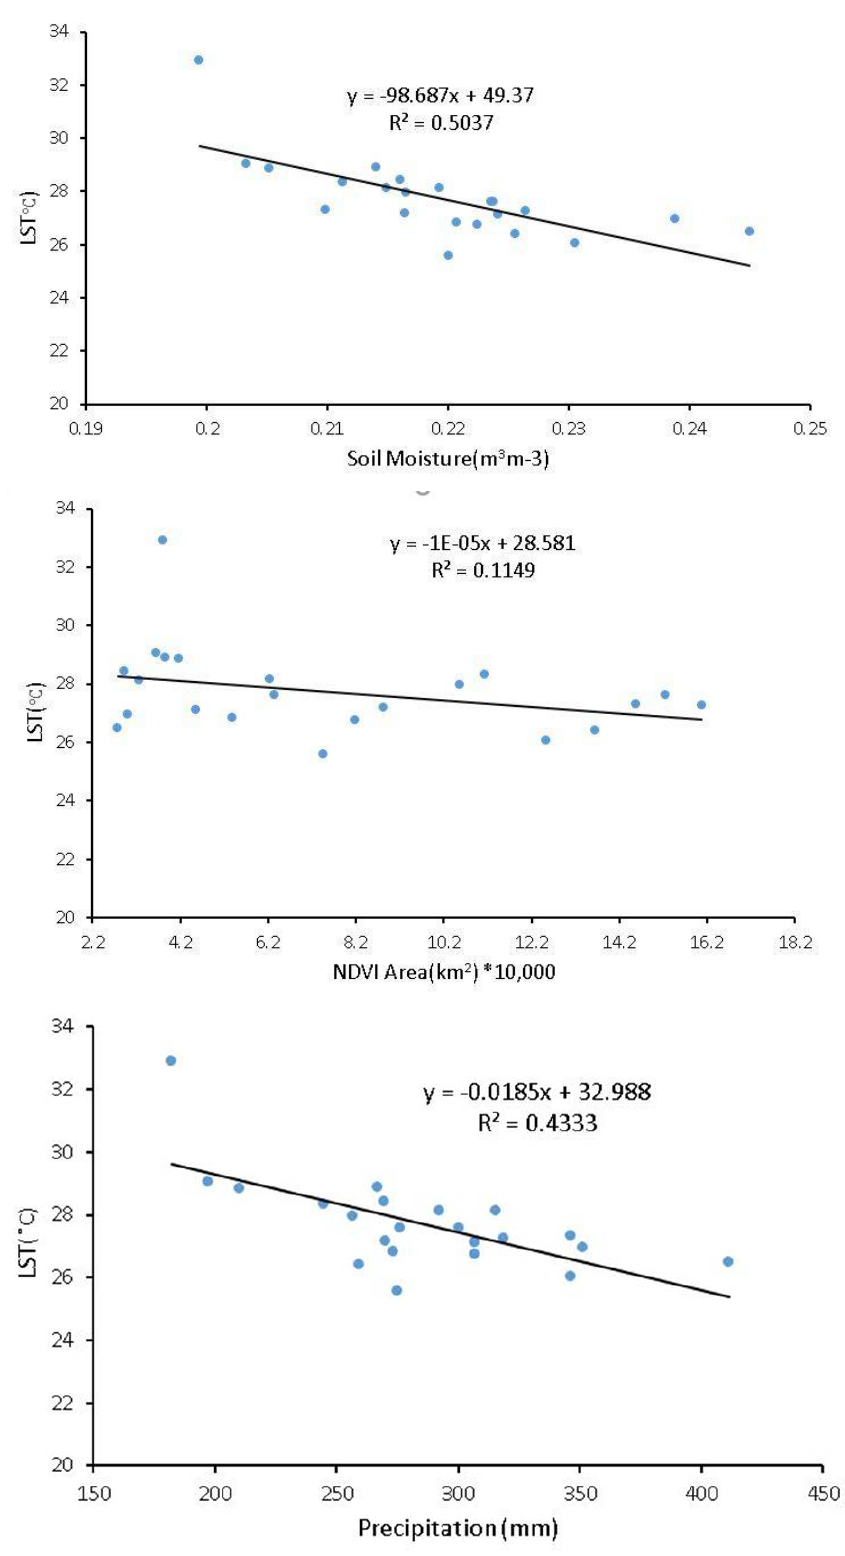
Figure 13. The scatter plots of relationships between annual country-wide means of LST and soil moisture (upper panel), vegetation coverage (middle panel), and precipitation (bottom panel) in Afghanistan in the period 2000–2021.